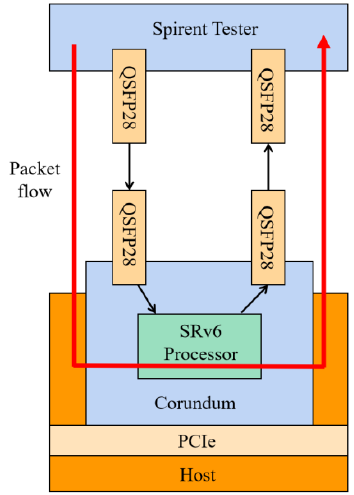
Figure 5. Prototype system test environment.